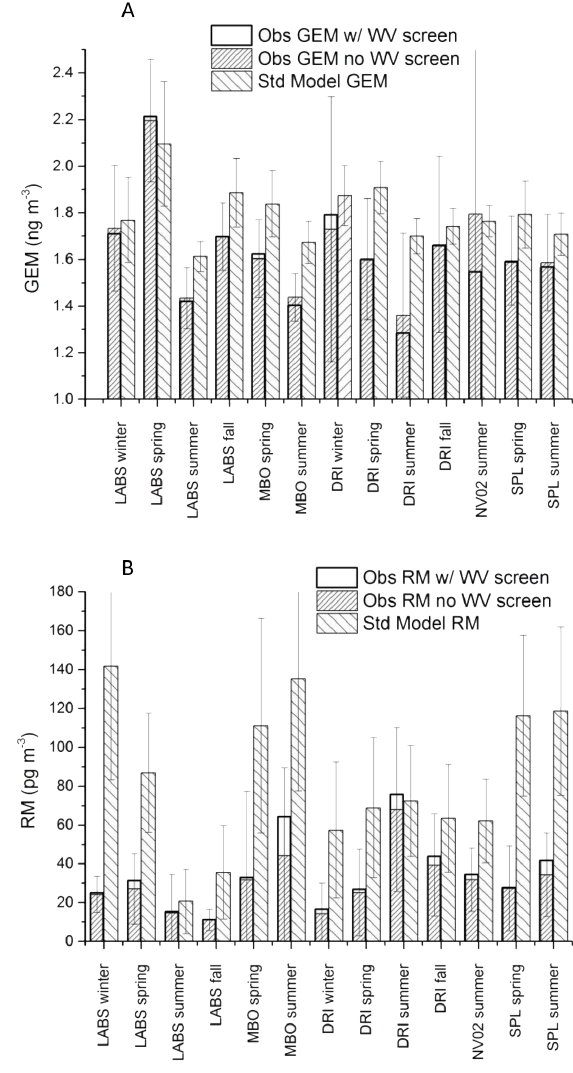
Figure 1. Means and standard deviations of observed and standard- modeled (a) GEM and (b) RM for each site by season. The WV- screened data are plotted in the same column as the unscreened